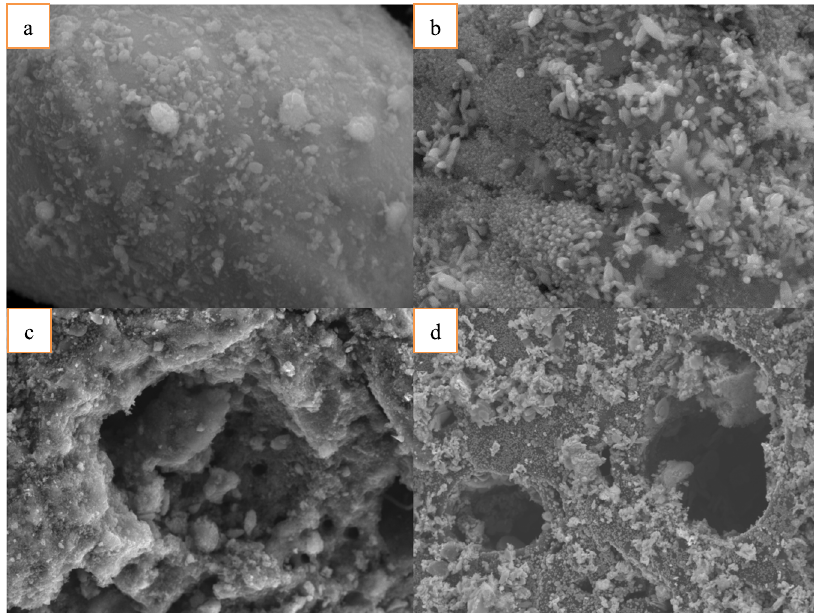
Figure 5. Surface characterization of ZVZ and AC before and after [C 4 mim][BF 4 ] degradation.